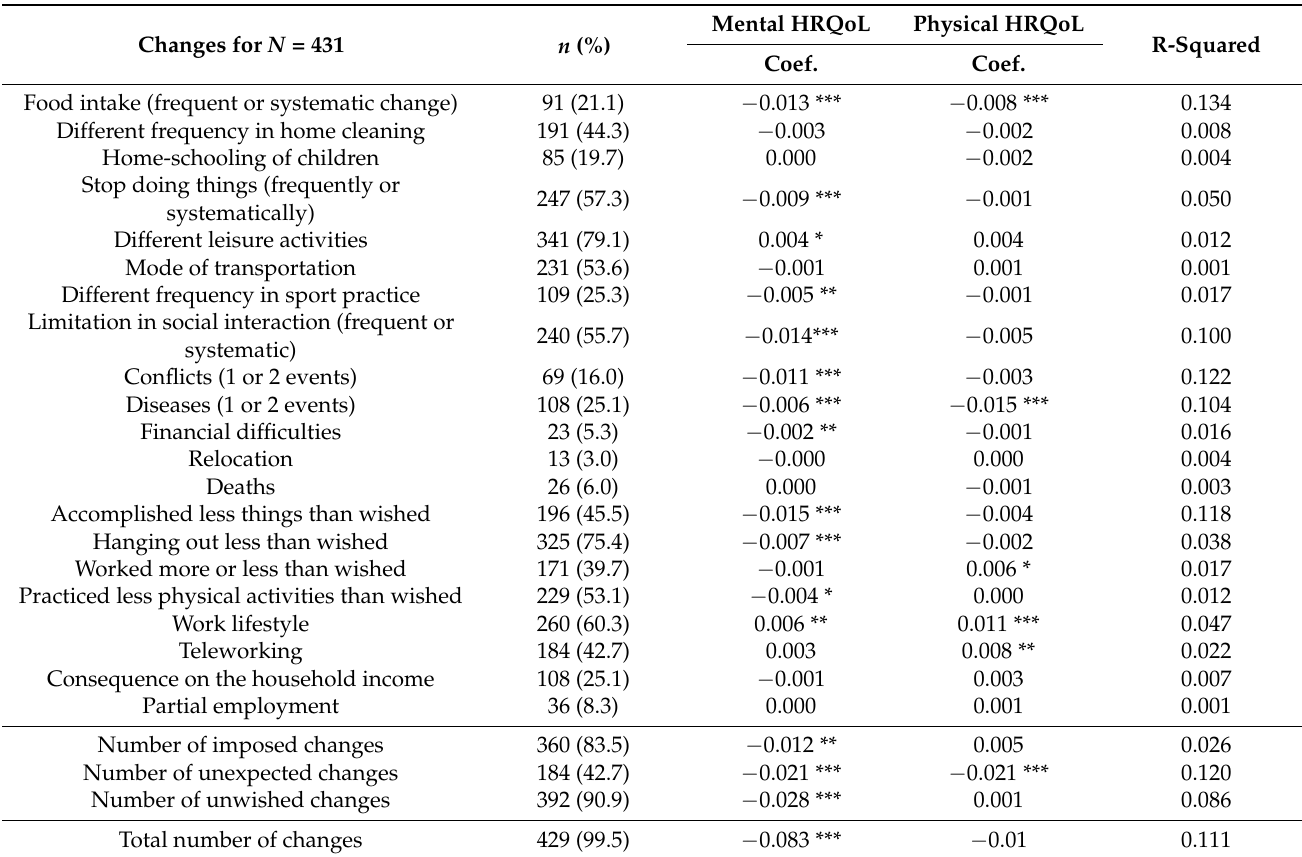
Table 2. Multivariate regression results of the mental and physical HRQoL score for the changes experienced. Changes for N =